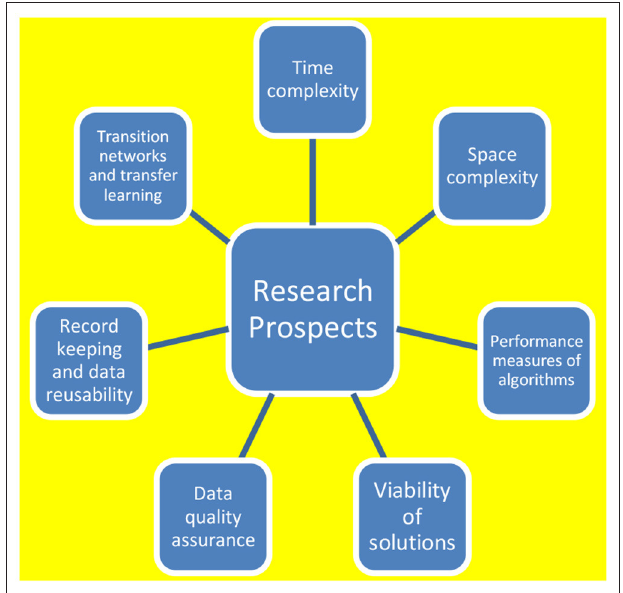
FIGURE 6 | Research